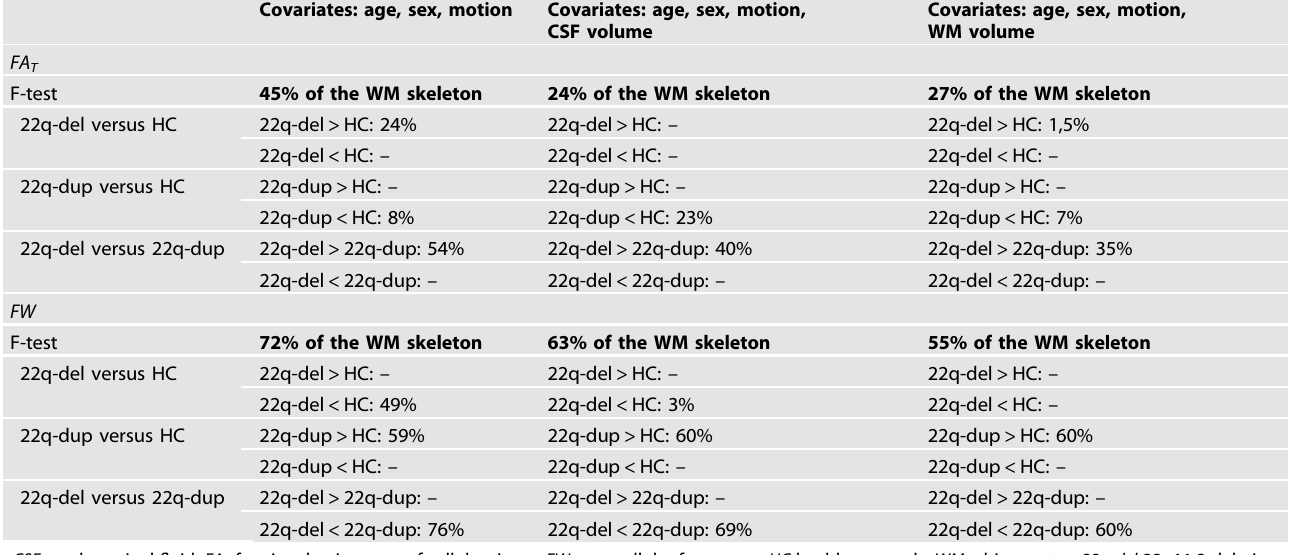
CSF cerebrospinal fl uid, FA T fractional anisotropy of cellular tissue, FW extracellular free-water, HC healthy controls, WM white matter, 22q-del 22q11.2 deletion carriers, 22q-dup 22q11.2 duplication carriers. *All group comparisons were conducted utilizing non-parametric voxel-wise permutation tests for each voxel on the WM skeleton in FSL ’ s Randomize [81]. We tested data against a null distribution generated with 5000 permutations for each contrast using threshold-free cluster enhancement [82] and family wise error correction at a signi fi cance level of p <0.05.